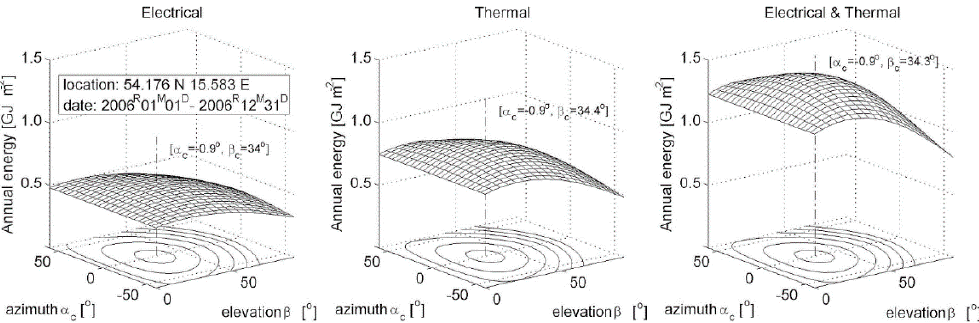
Figure 5. Optimal orientation of the absorber surface in selected year.